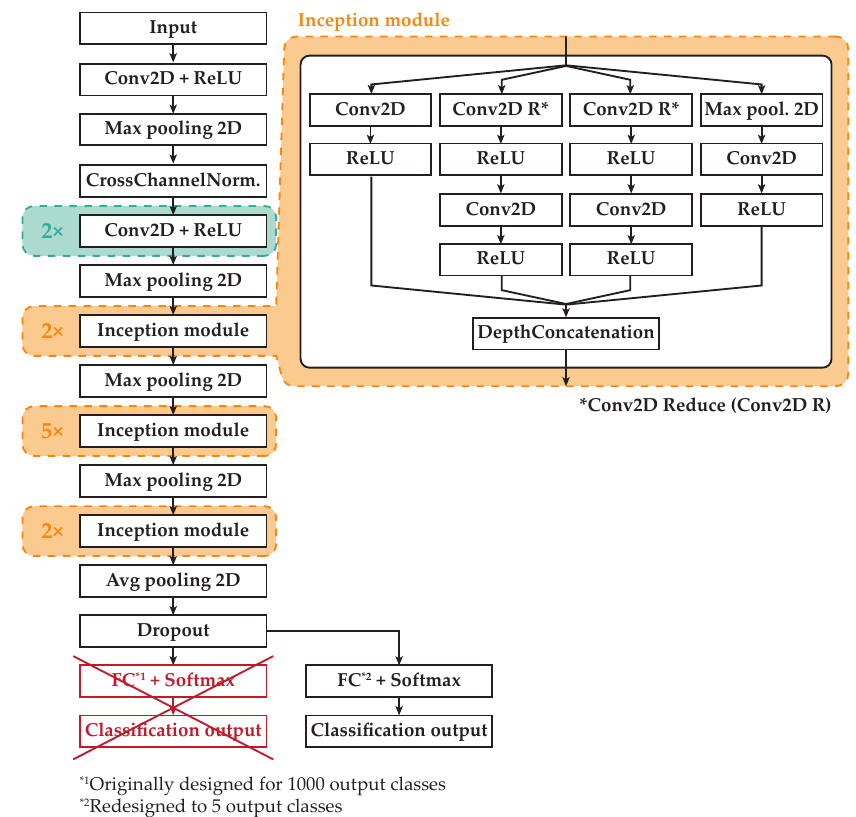
Figure 14. Architecture modification of the pretrained GoogLeNet.